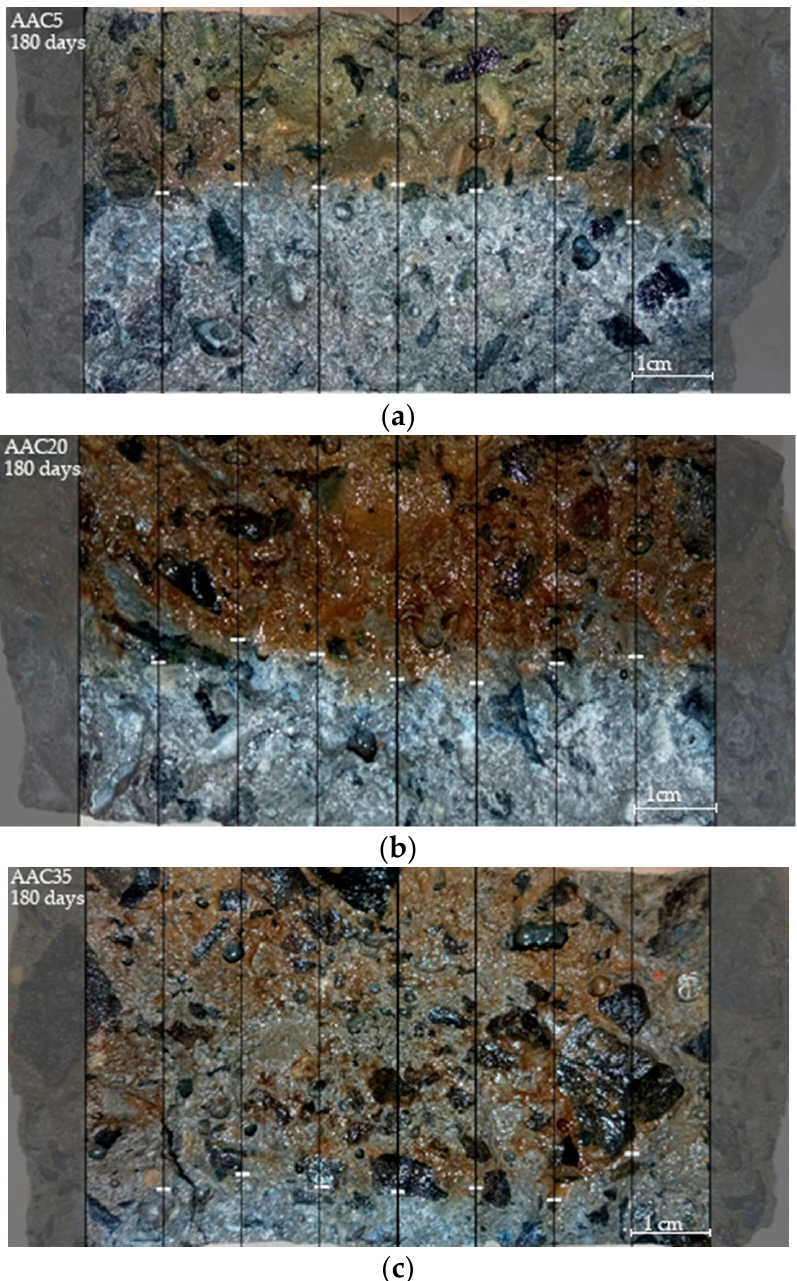
Figure 6. Chloride penetration depths of alkali-activated concretes after 180 days: ( a ) AAC5; ( b ) AAC20; ( c ) AAC35. The average values and standard deviations of chloride penetration depth for each sample are presented in Table 4. The results of chloride transport in AACs indicate a strong correlation with GGBFS content: the chloride penetration depth for AAC5 is almost twice that of AAC20, which is more than quadruple that of AAC35. Slag’s impact is therefore clearly pointed